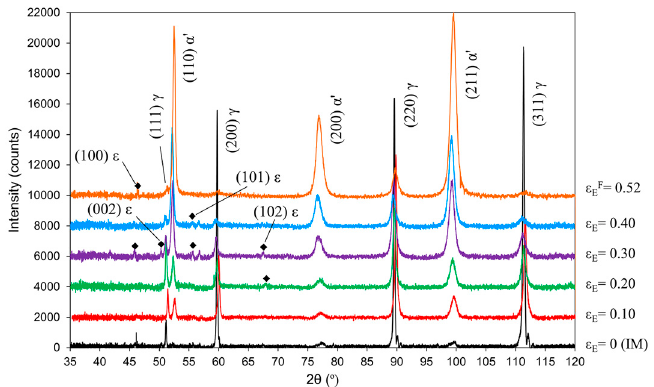
Figure 2. X-ray diffractograms for the initial microstructure (IM) and interrupted tensile-tested specimens at strains ( ε E ) of 0.10, 0.20, 0.30, 0.40, and fracture ( ε E = 0.52). Diamond dots indicate the presence of peaks associated to ε -martensite phase.